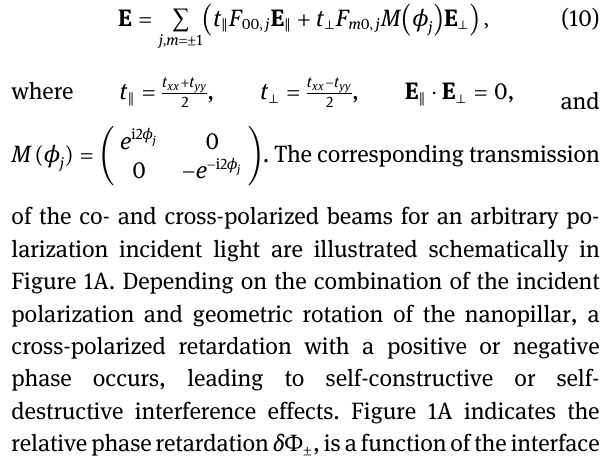
destructive interference effects. Figure 1A indicates the relative phase retardation δ Φ ± , is a function of the interface lateral displacement δ ( x ) between copolarized and cross-